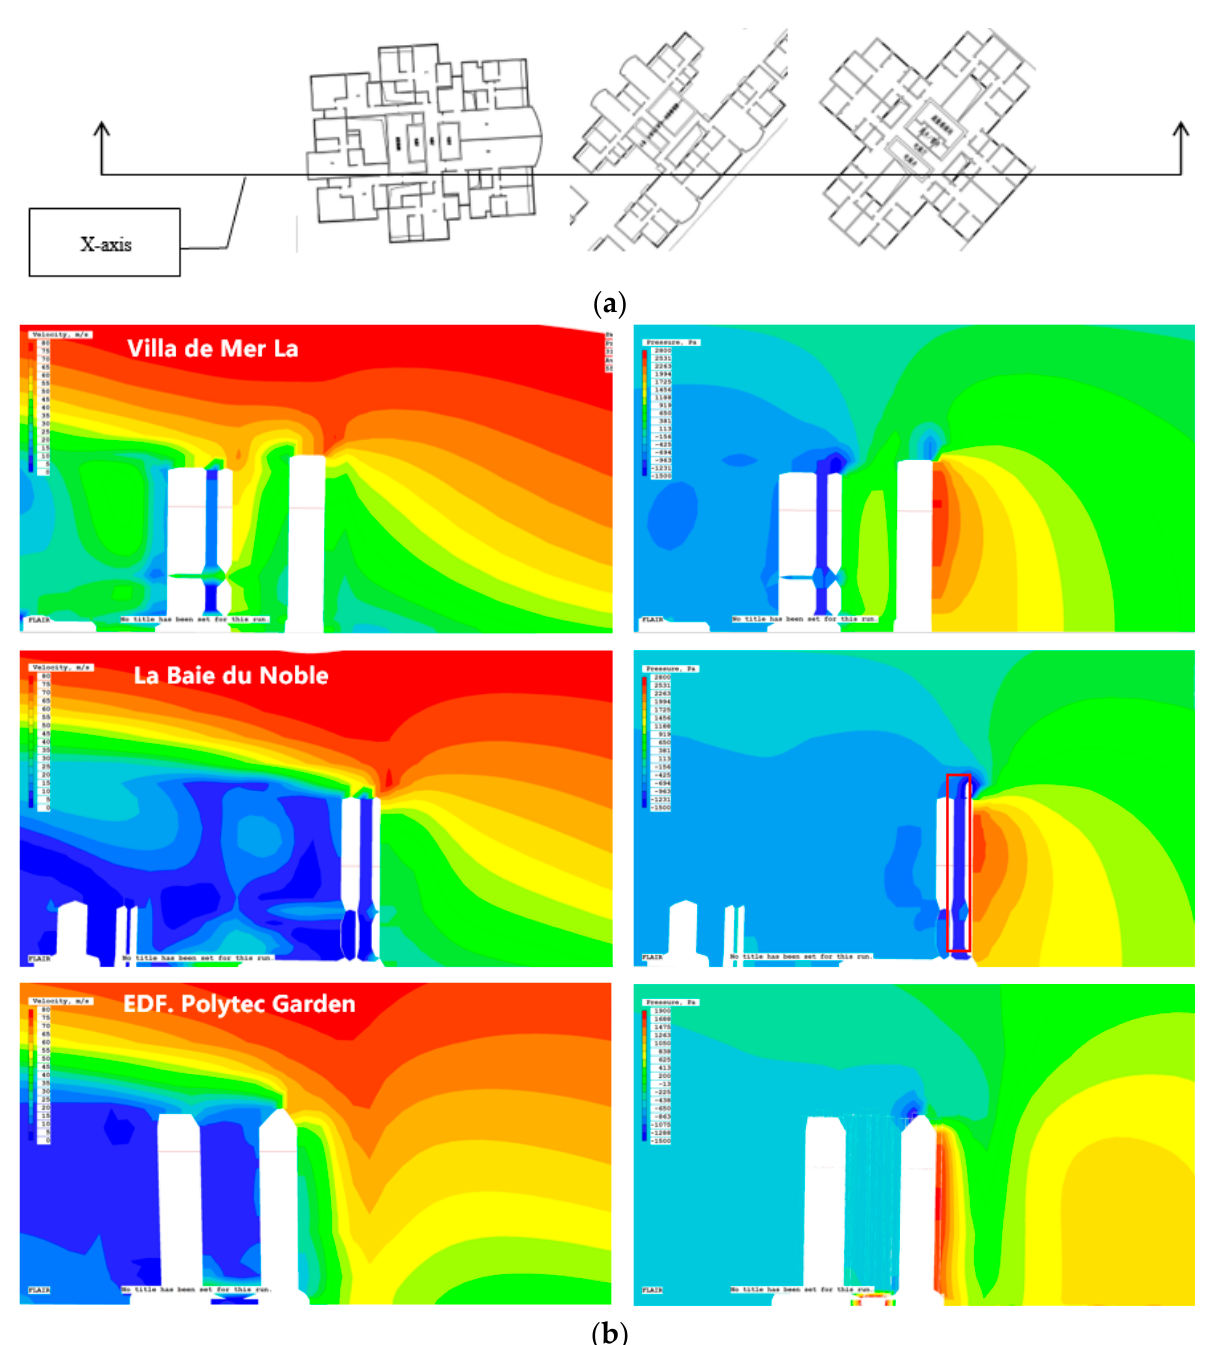
Figure 11. ( a ) X-axis slice position top view; and ( b ) Cloud chart of X-axis section of wind speed and wind pressure nephogram. In the floor plan ( a ), the Chinese text indicates the location of the elevator room of the